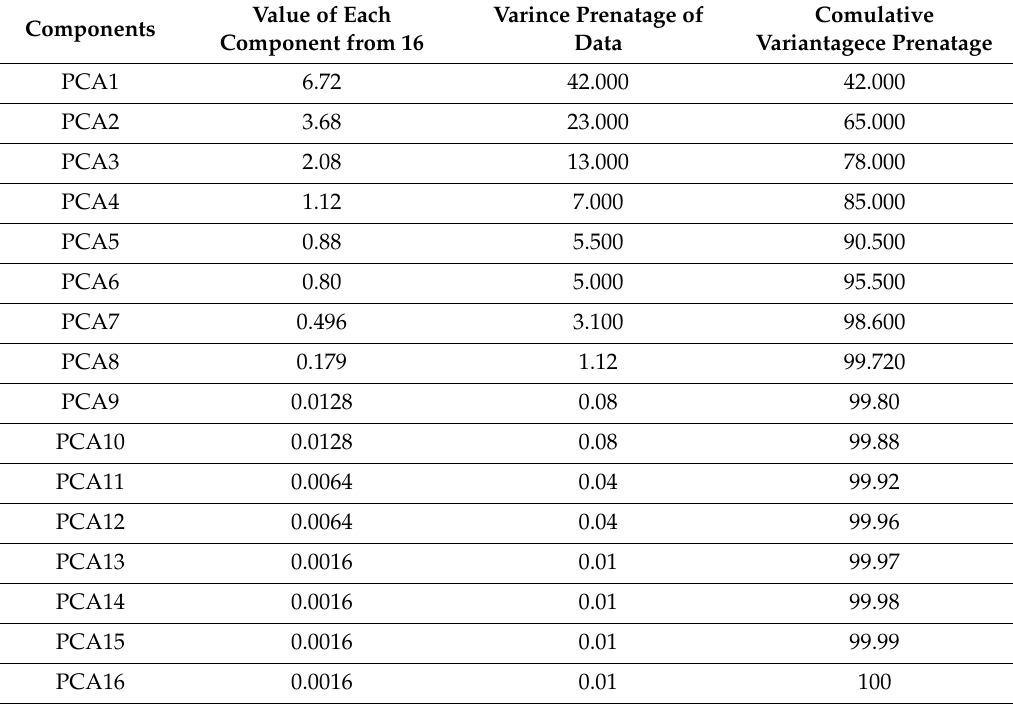
Table 2. Computed value for each component, the computed comulative varince for each component.